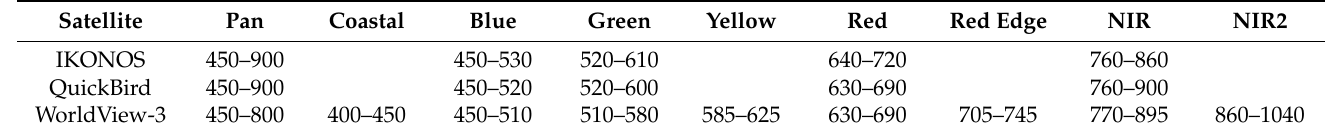
Table 2. Band settings of different